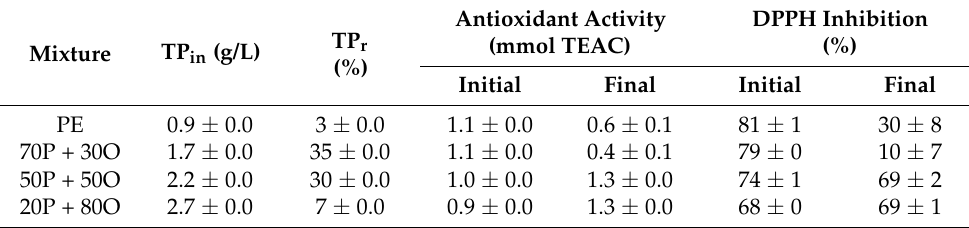
Table 6. Anaerobic digestion of PE + OMW: Antioxidant activity and total phenolic (TP) content.